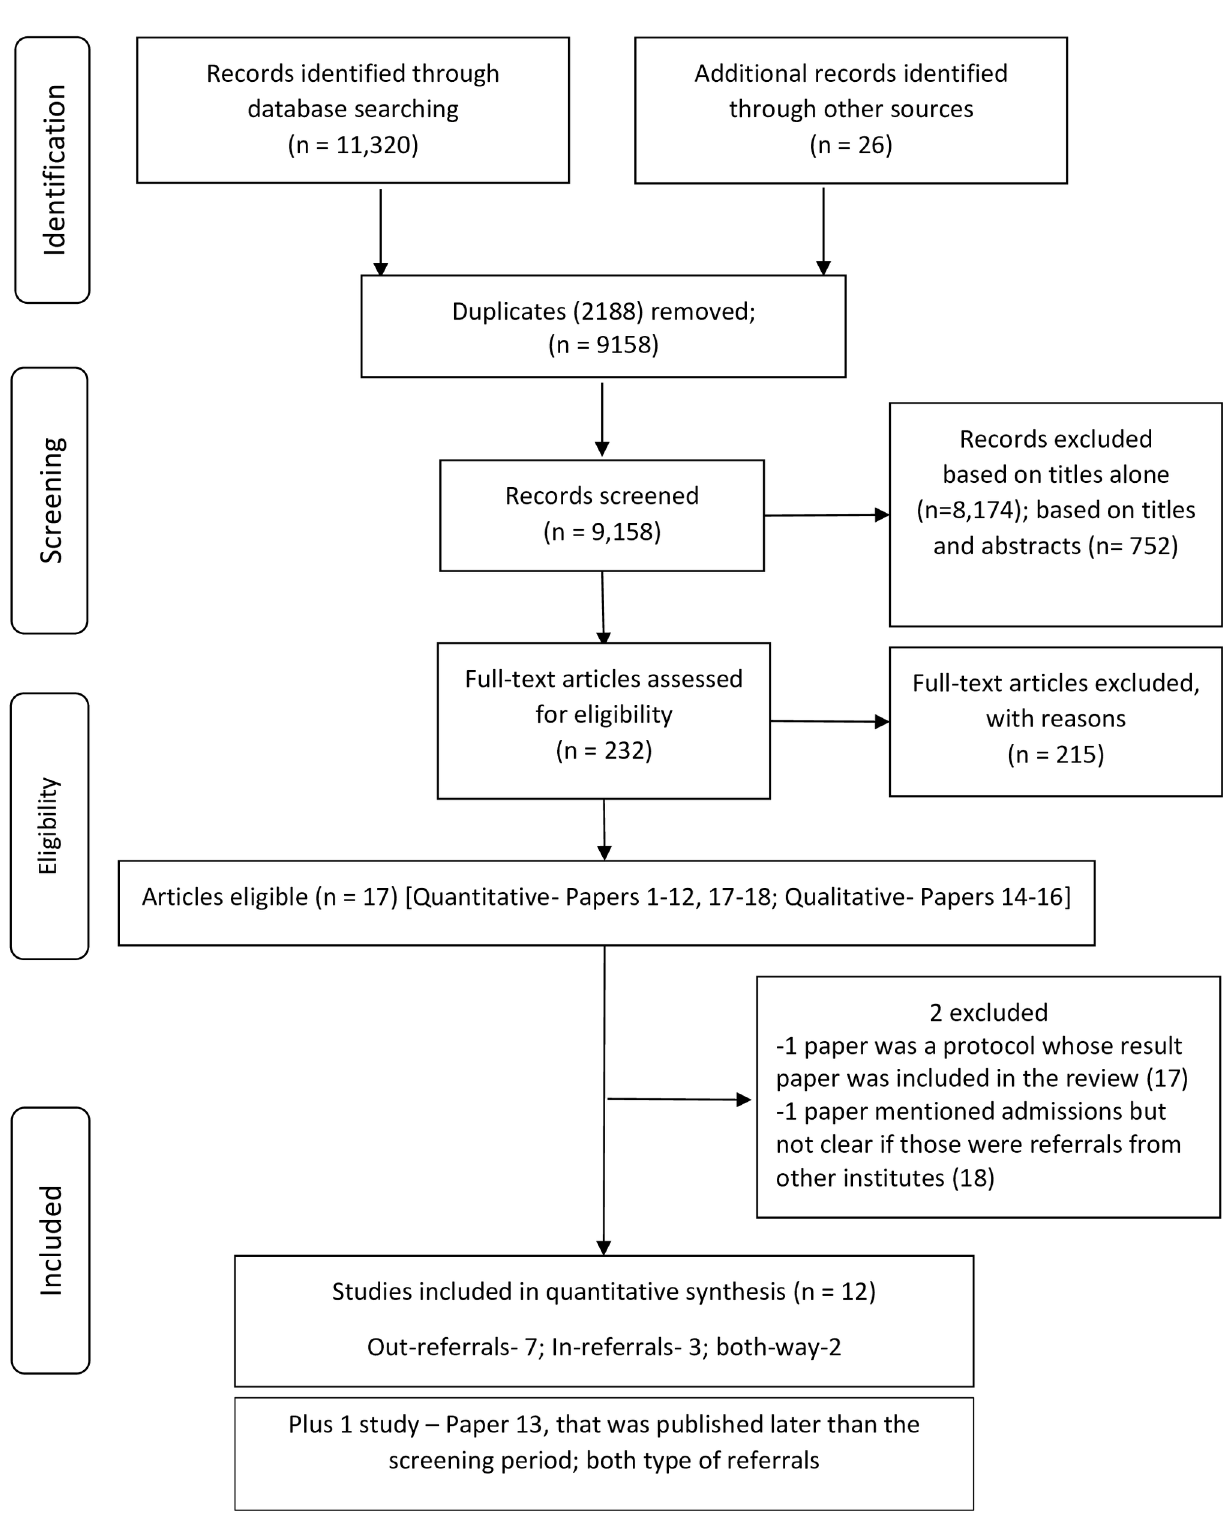
Fig 2. PRISMA Flow Diagram for Systematic Review.